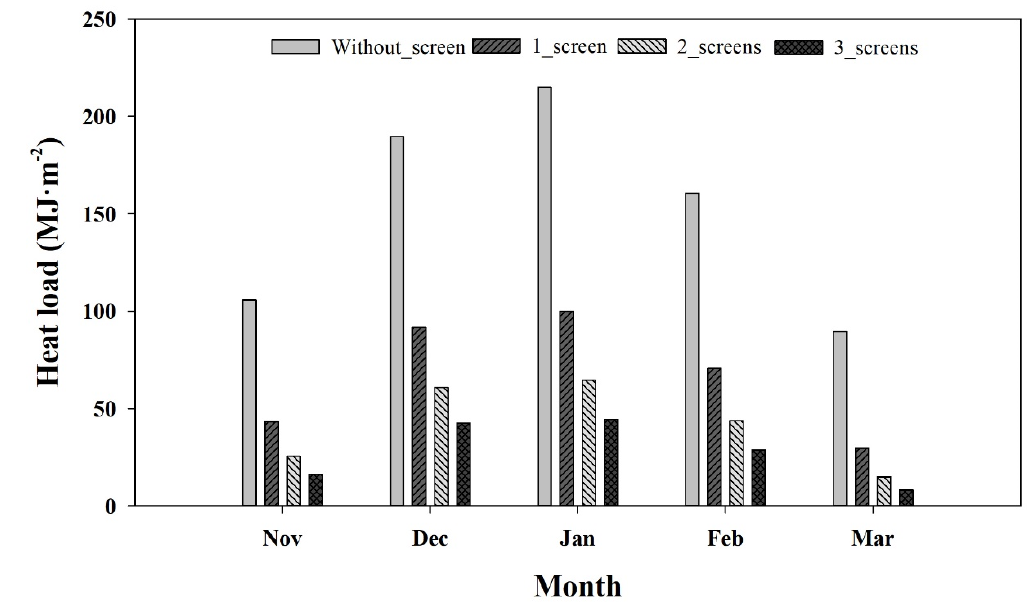
Figure 11. Monthly heating load of a greenhouse without a screen and with single, double, and triple screens.